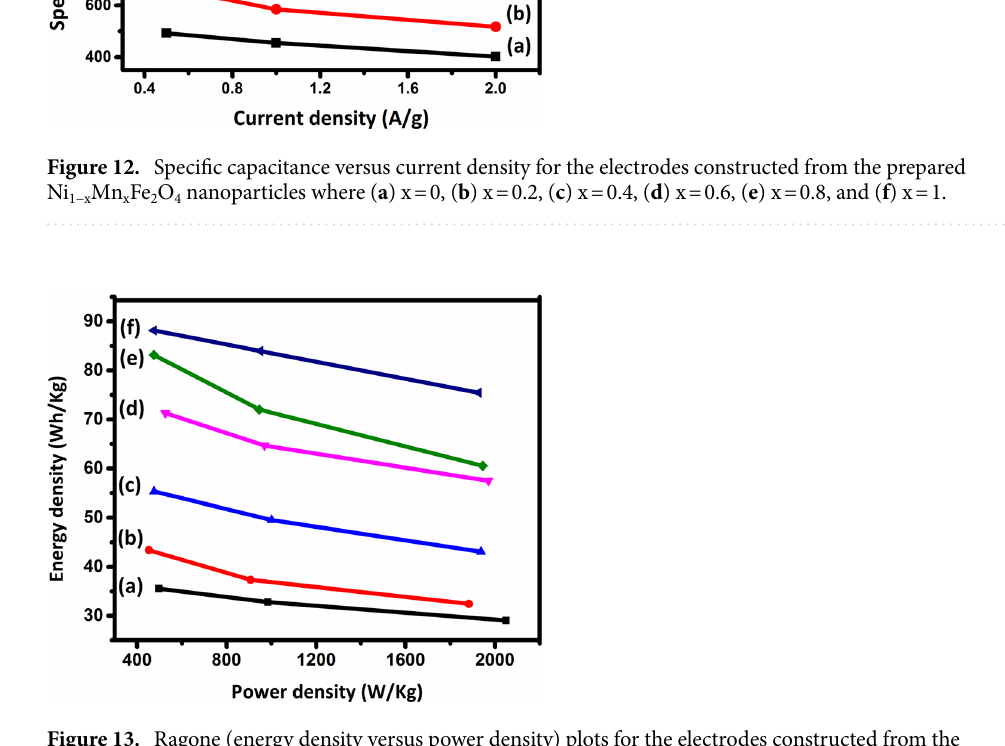
Figure 13. Ragone (energy density versus power density) plots for the electrodes constructed from the prepared